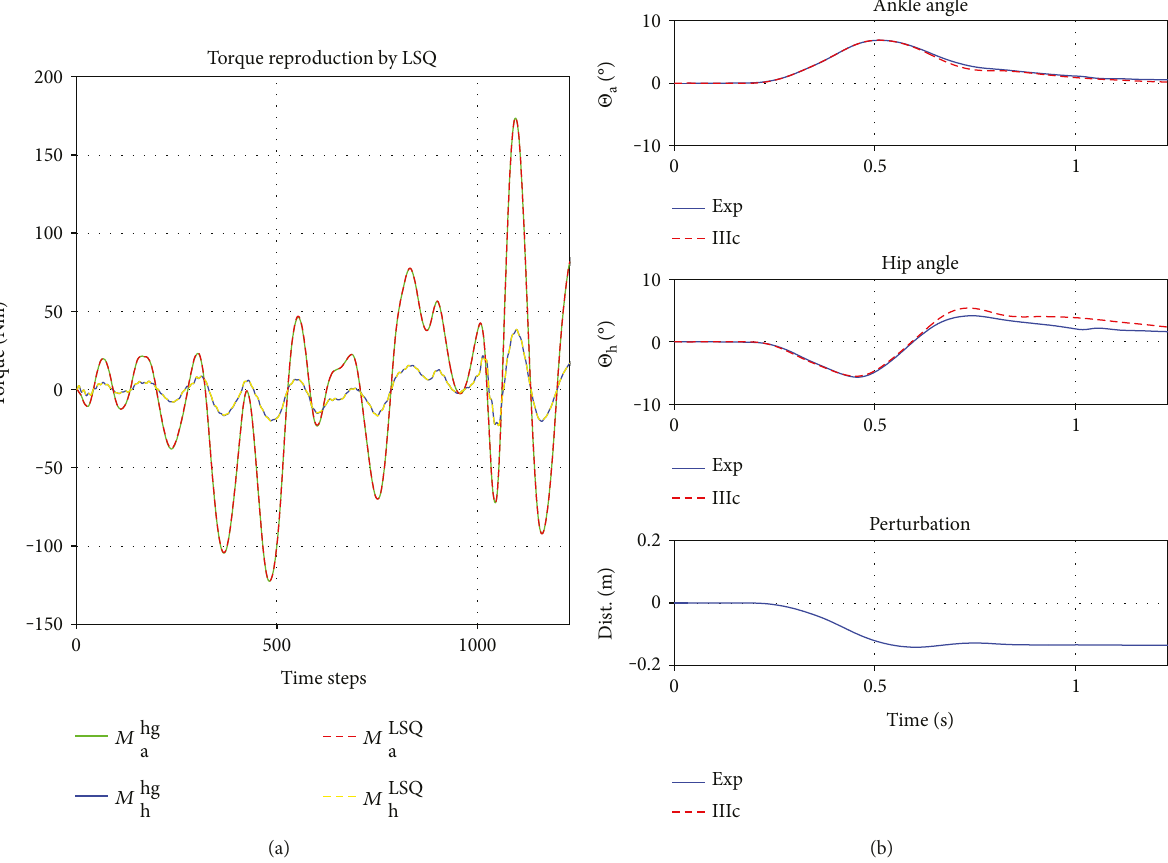
versus M LSQ , i ∈ a , h with virtually M LSQ = M sim . y -axis is torque in Nm over i i referred to by IIIc . tr avrg